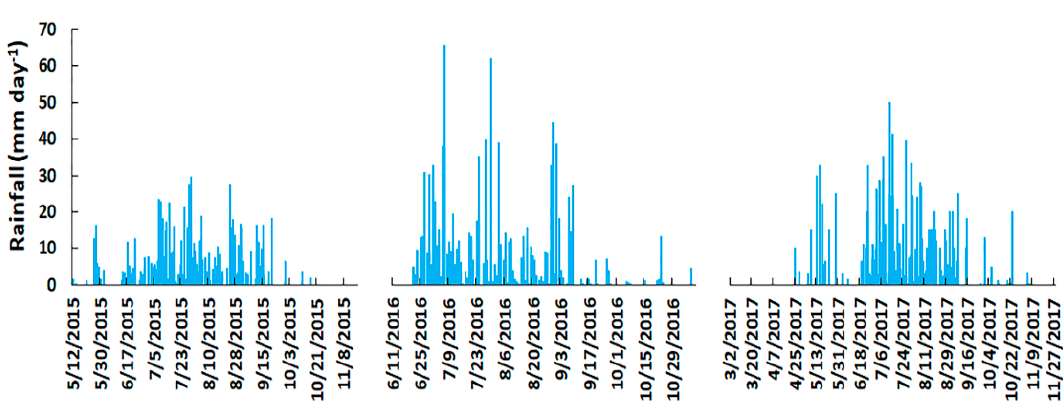
Figure 4. Daily rainfall of Gomit watershed.